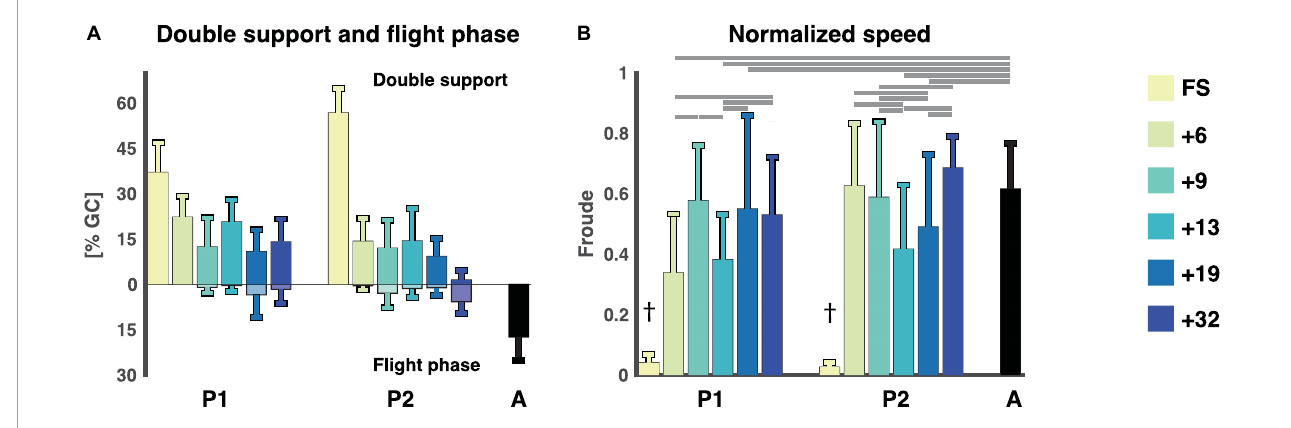
FIGURE2 Temporal gait parameters. (A) Flight phase and double support phase as a percentage of the gait cycle (mean ± std). Double support phases are on the top with flight phases being the negative percentages below. (B) The normalized speed expressed as the Froude number (v 2 / g · l) for each session and participant (mean ± std). † Denotes a significant difference between current session and all other sessions for that participant as well as adults ( p < 0 . 007). Horizontal lines denote significant differences between the Froude numbers for the sessions. A: adults, FS: first steps, %GC: percentage gait cycle, +6, +9, +13, +19, +32 refers to the number of months since onset of independent walking.